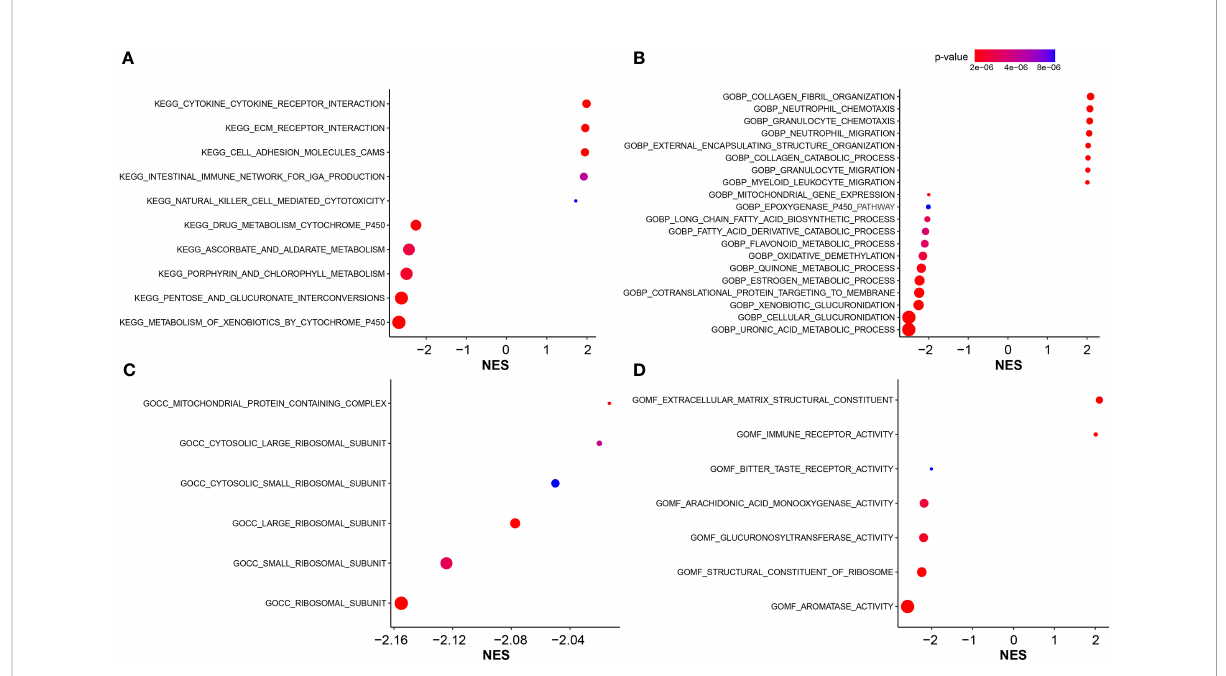
FIGURE 7 The functional enrichment analysis. (A) The KEGG pathway enrichment analysis for identi fi cation of biological functions associated with FARG signature. (B) The GO enrichment analysis for identi fi cation of biological processes (GOBP) associated with FARG signature. (C) The GO enrichment analysis for identi fi cation of cellular components (GOCC) associated with FARG signature. (D) The GO enrichment analysis for identi fi cation of molecular functions (GOMF) associated with FARG